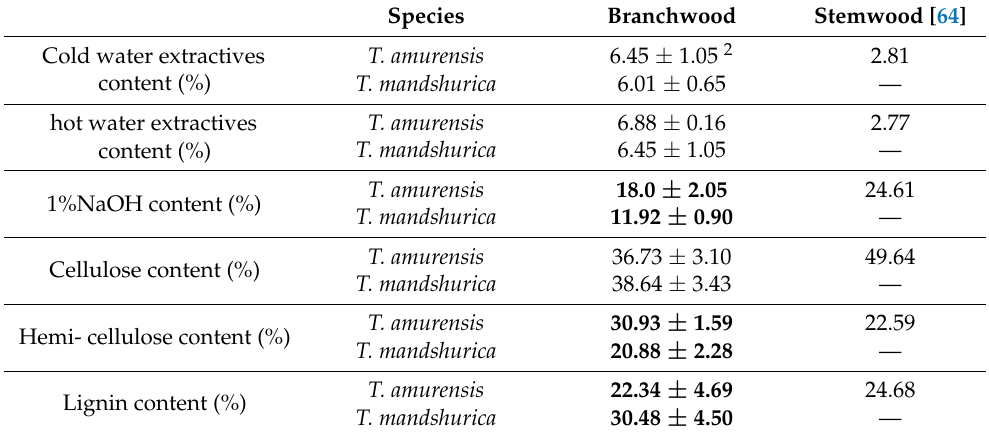
Table 6. Comparison of chemical composition of branchwood and stemwood from two Tilia species 1 . Species Branchwood Stemwood [64] Cold water extractives content